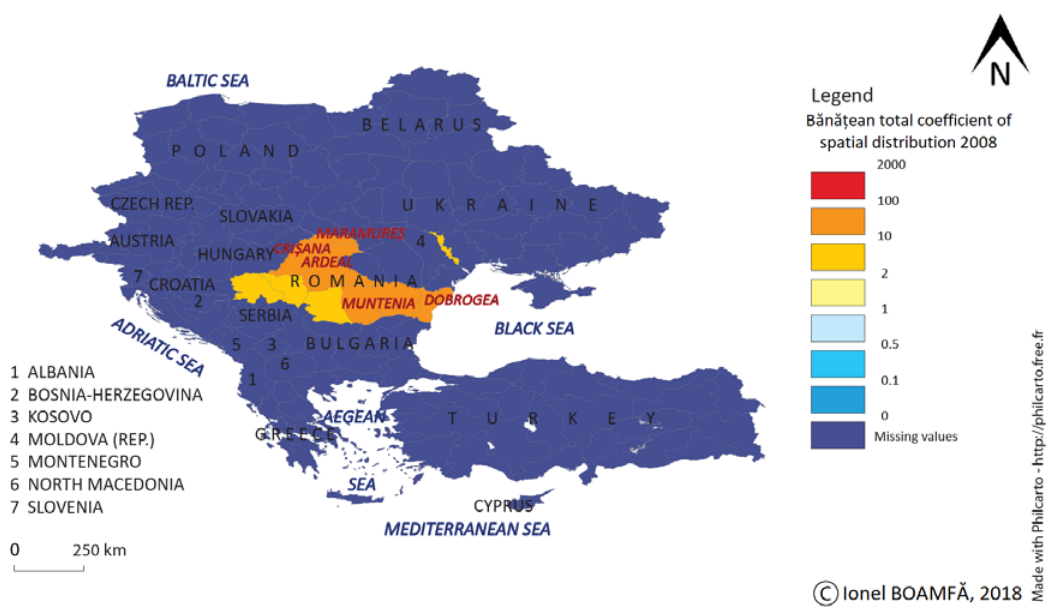
Figur e 12 . G eographical repartition of the anthroponym Bănățean . Coef. of spatial